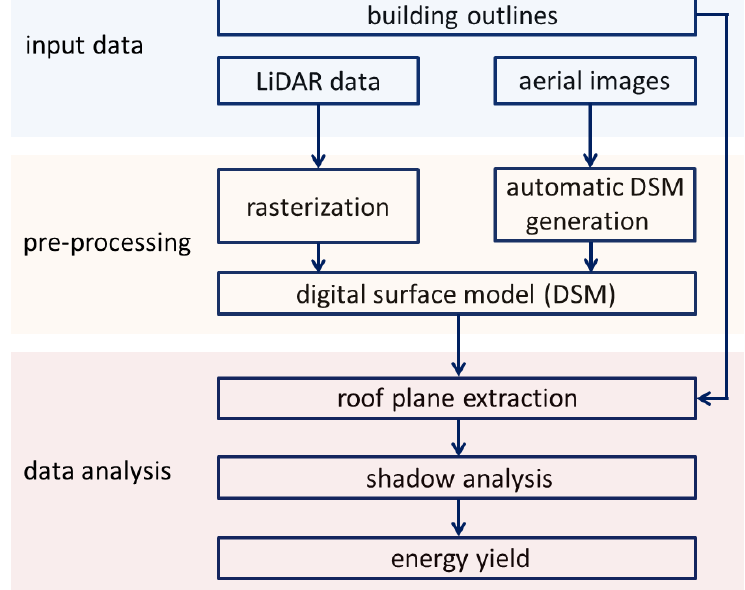
Figure 1. Principle workflow of the system for extraction of suitable roof planes for solar energy installations. LiDAR or aerial image data can be used. Building outlines are introduced to mask out prospective roof areas.